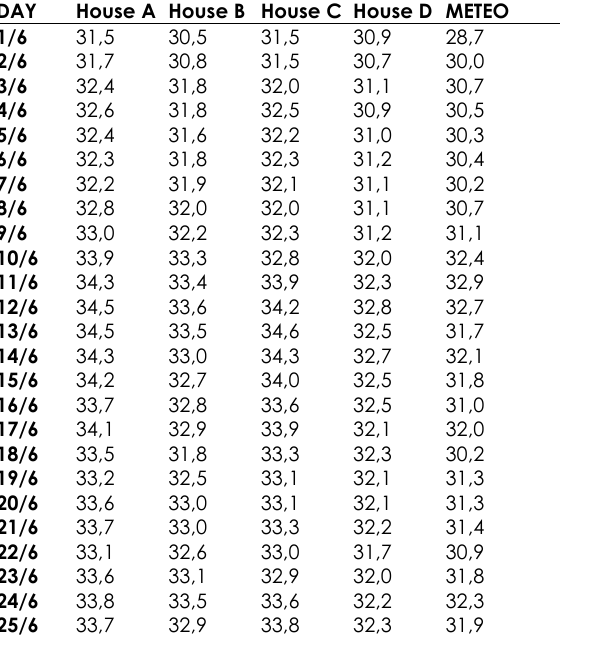
Table 1 . Measured air temperatures for Figure 9 and their mean value